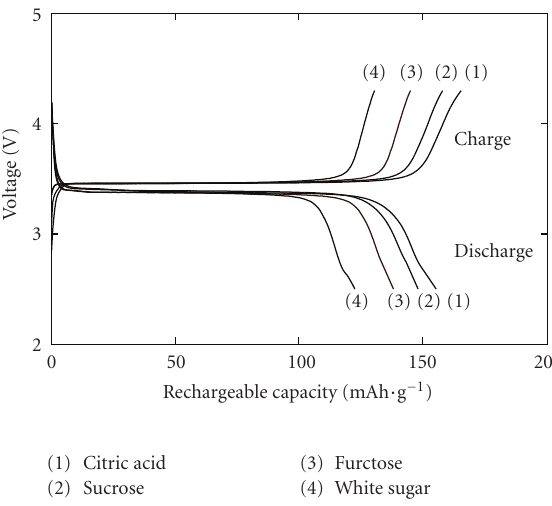
Figure 5: Rechargeable curves of LiFePO 4 /C cathode at 1